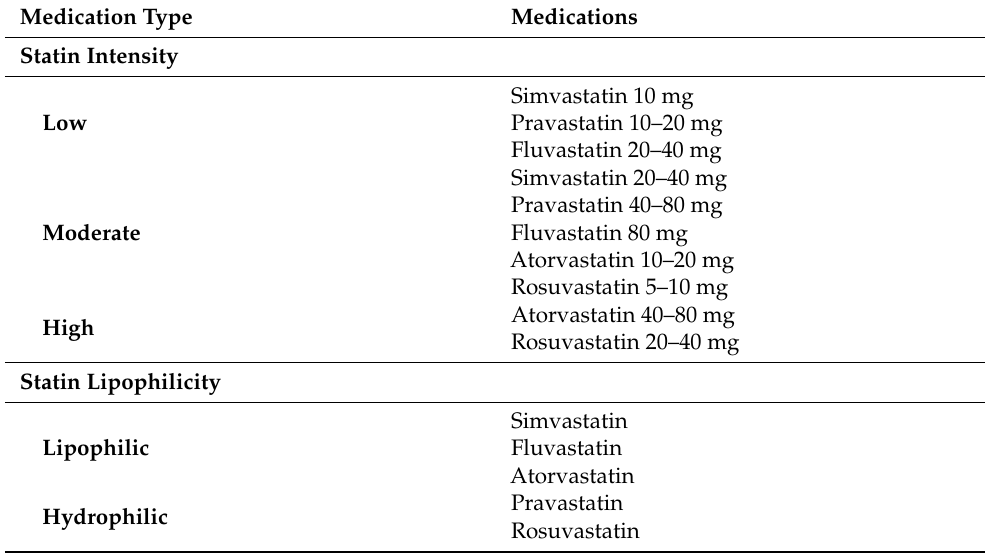
Table A2. Classifications of different statins based on intensity and lipophilicity.